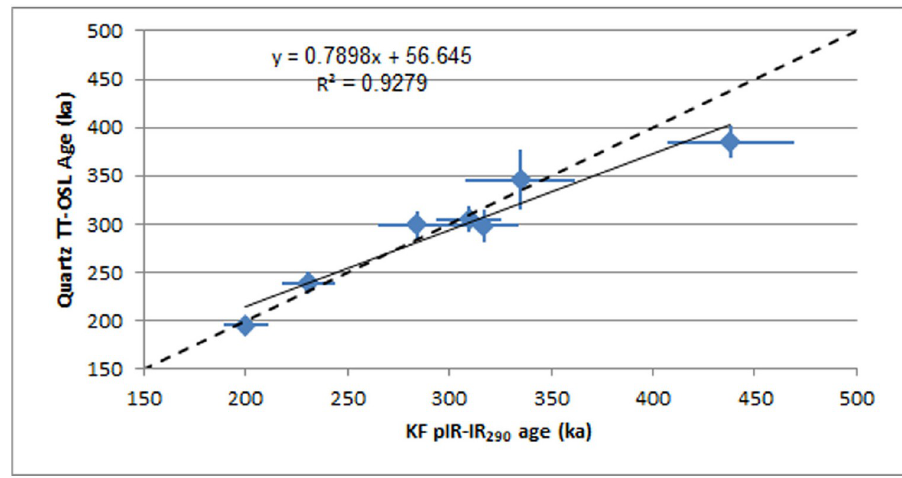
Fig 7. A comparison of ages obtained by TT-OSL on quartz and pIR-IR290 on